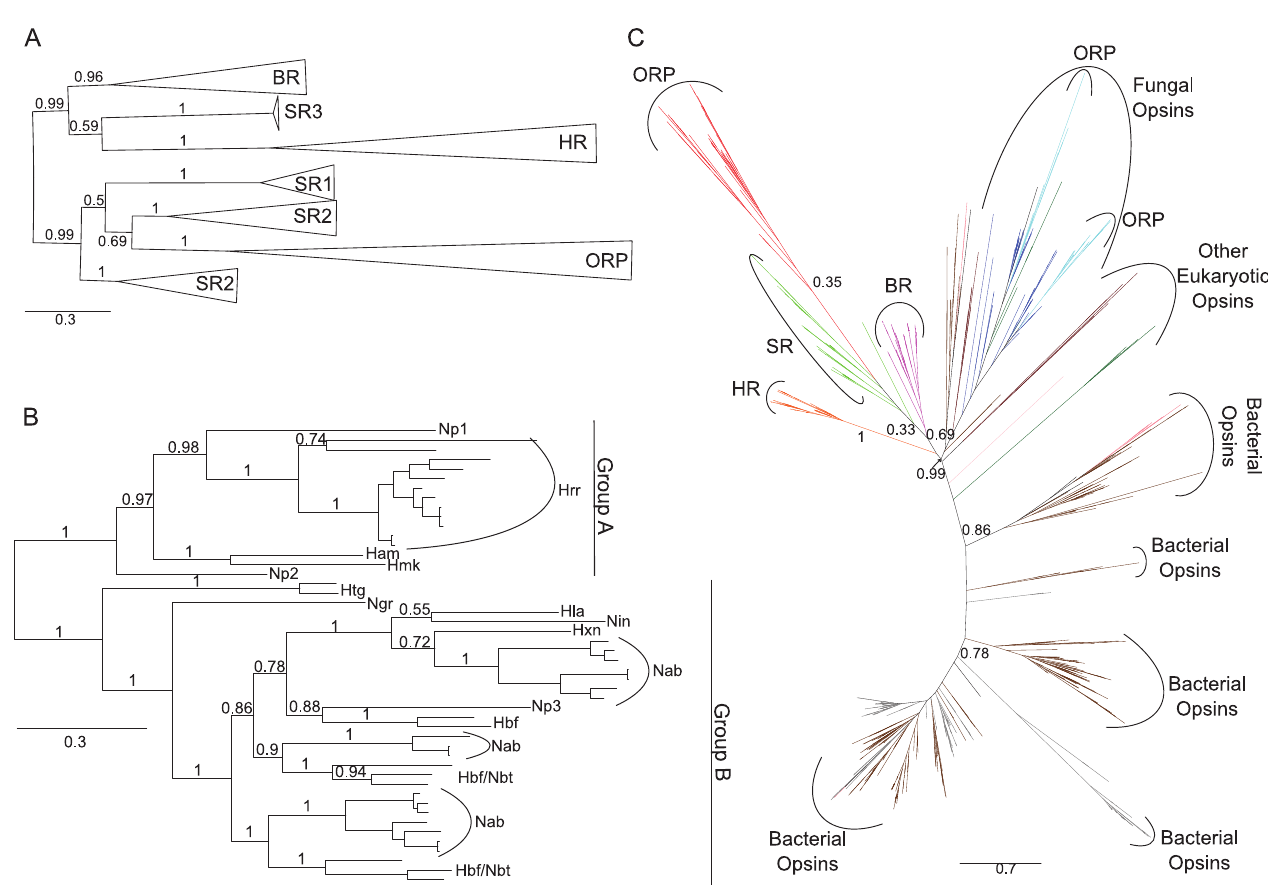
Fig 2. Phylogenies of haloarchaeal and microbial (type 1) opsins. A. Phylogenetic tree of 170 haloarchaeal opsin proteins constructed using Bayesian inference with MrBayes. Individual members of each opsin family were collapsed to indicate relationship among classes. Triangle length is proportional to sequence diversity within clade, triangle width is not significant. Abbreviations as in Fig 1. For fully expanded tree see S5 Fig. Tree file can be accessed at the Dryad Digital Repository (http://dx.doi.org/10.5061/dryad.963hr). B. Bayesian inference phylogenetic tree of novel class of putatively retinal-free sensory opsins extracted from tree in Fig 2A. Np = Natronomonas pharaonis , Hrr = Halorubrum , Ham = Hararcula amylolytica , Hmk = Halomicrobium mukohataei , Htg = Haloterrigena , Ngr = Natrialba gregoryi , Hla = Halobiforma lacisalsi , Nin = Natronolimnobius innermongolicus , Hxn = Halopiger xanaduensis , Nab = Natrialba , Hbf = Halobiforma , Nbt = Natronobacterium . C. Maximum-likelihood phylogeny of all microbial (type 1) opsins obtained by BLASTp search of NCBI ’ s nr and env_nr databases. Tree inferred using FastTree [71]